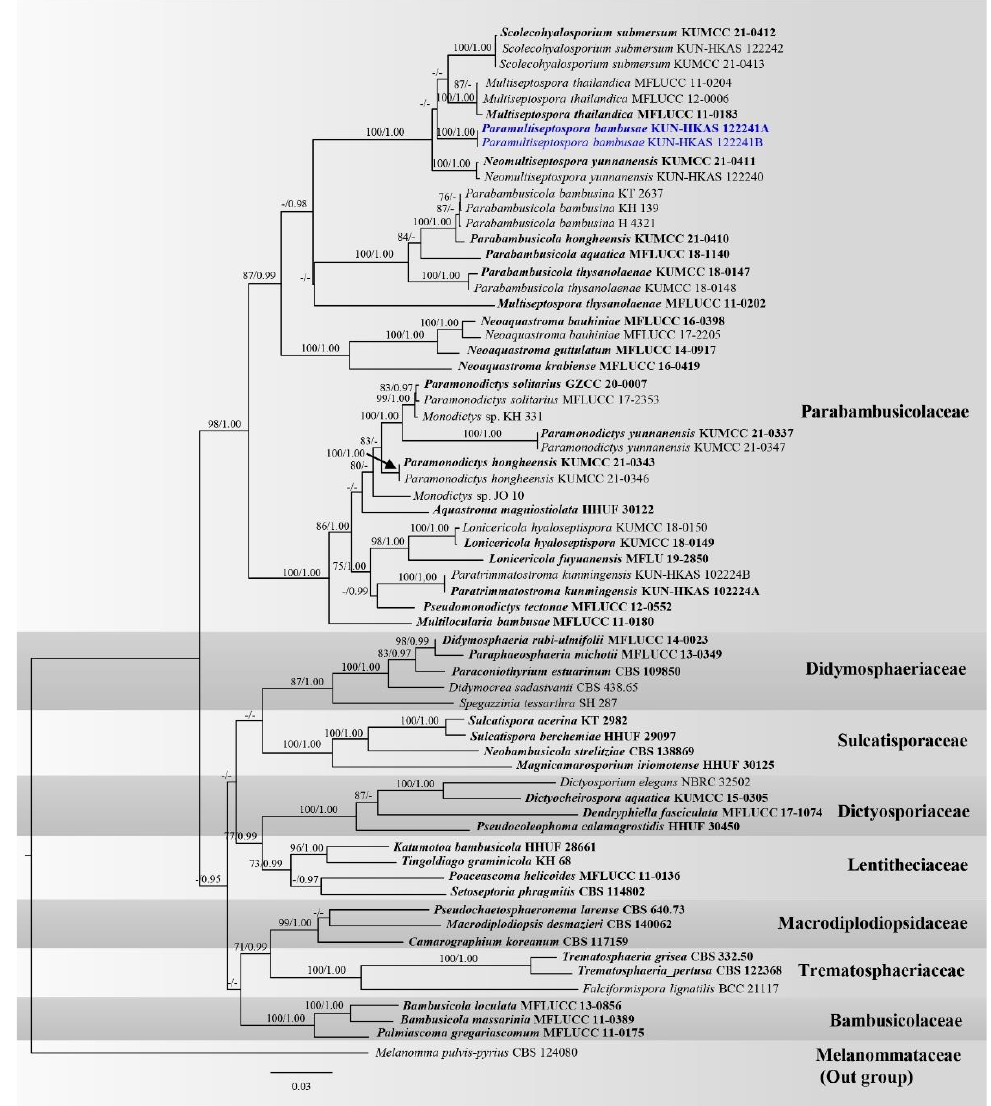
Figure 2. Phylogram generated from RAxML analysis of a concatenated ITS-LSU-SSU- tef1- α sequence dataset to represent the phylogenetic relationships of novel taxa in Parabambusicolaceae with other related families in Pleosporales. Bootstrap support values for ML equal to or greater than 70% and the Bayesian posterior probabilities equal to or higher than 0.95 PP are indicated above the nodes as ML/PP. Support values lower than 70% ML and 0.95 PP are indicated by a hyphen (-). Ex-type strains are in bold, and the new species is indicated in blue. The arrow in the figure is indicated the support value at the node.